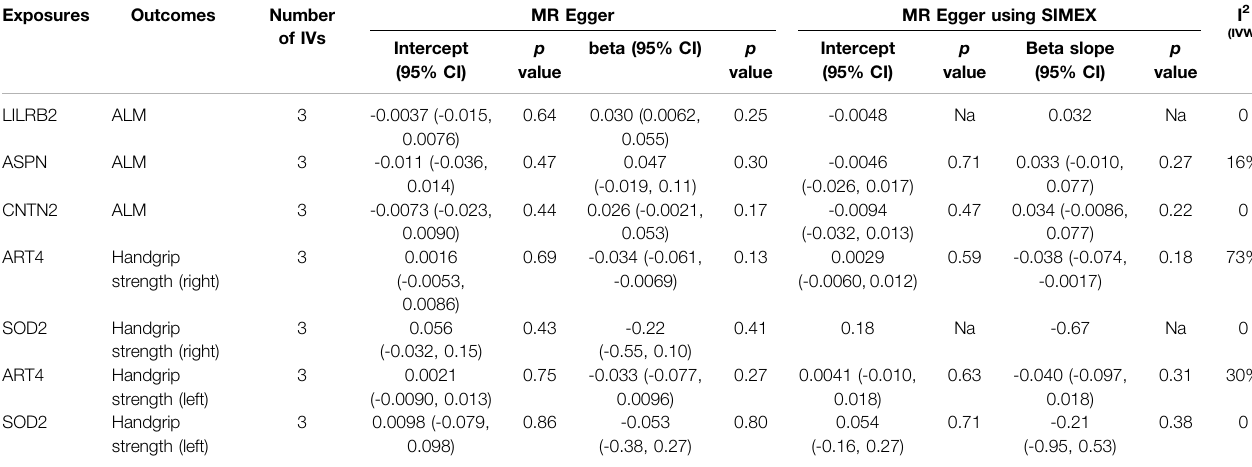
TABLE 7 | Association between plasma proteins and sarcopenia-related traits using MR Egger and MR Egger using SIMEX. Exposures